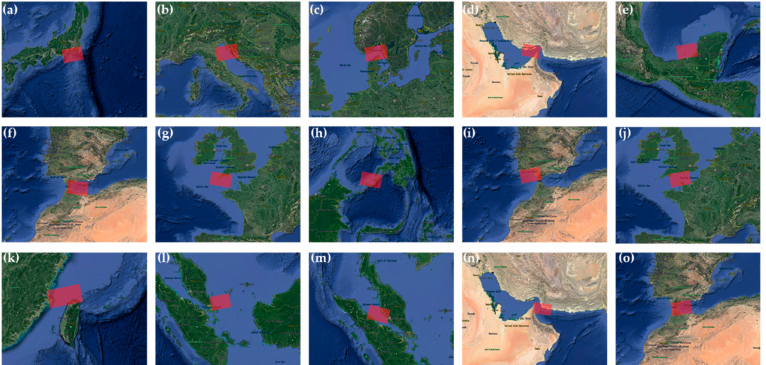
Figure 3. Coverage areas. ( a ) Tokyo Port; ( b ) Adriatic Sea; ( c ) Skagerrak; ( d ) Qushm Islands; ( e ) Campeche; ( f ) Alboran Sea; ( g ) Plymouth; ( h ) Basilan Islands; ( i ) Gulf of Cadiz; ( j ) English Channel; ( k ) Taiwan Strait; ( l ) Singapore Strait; ( m ) Malacca Strait; ( n ) Gulf of Cadiz; ( o ) Gibraltarian